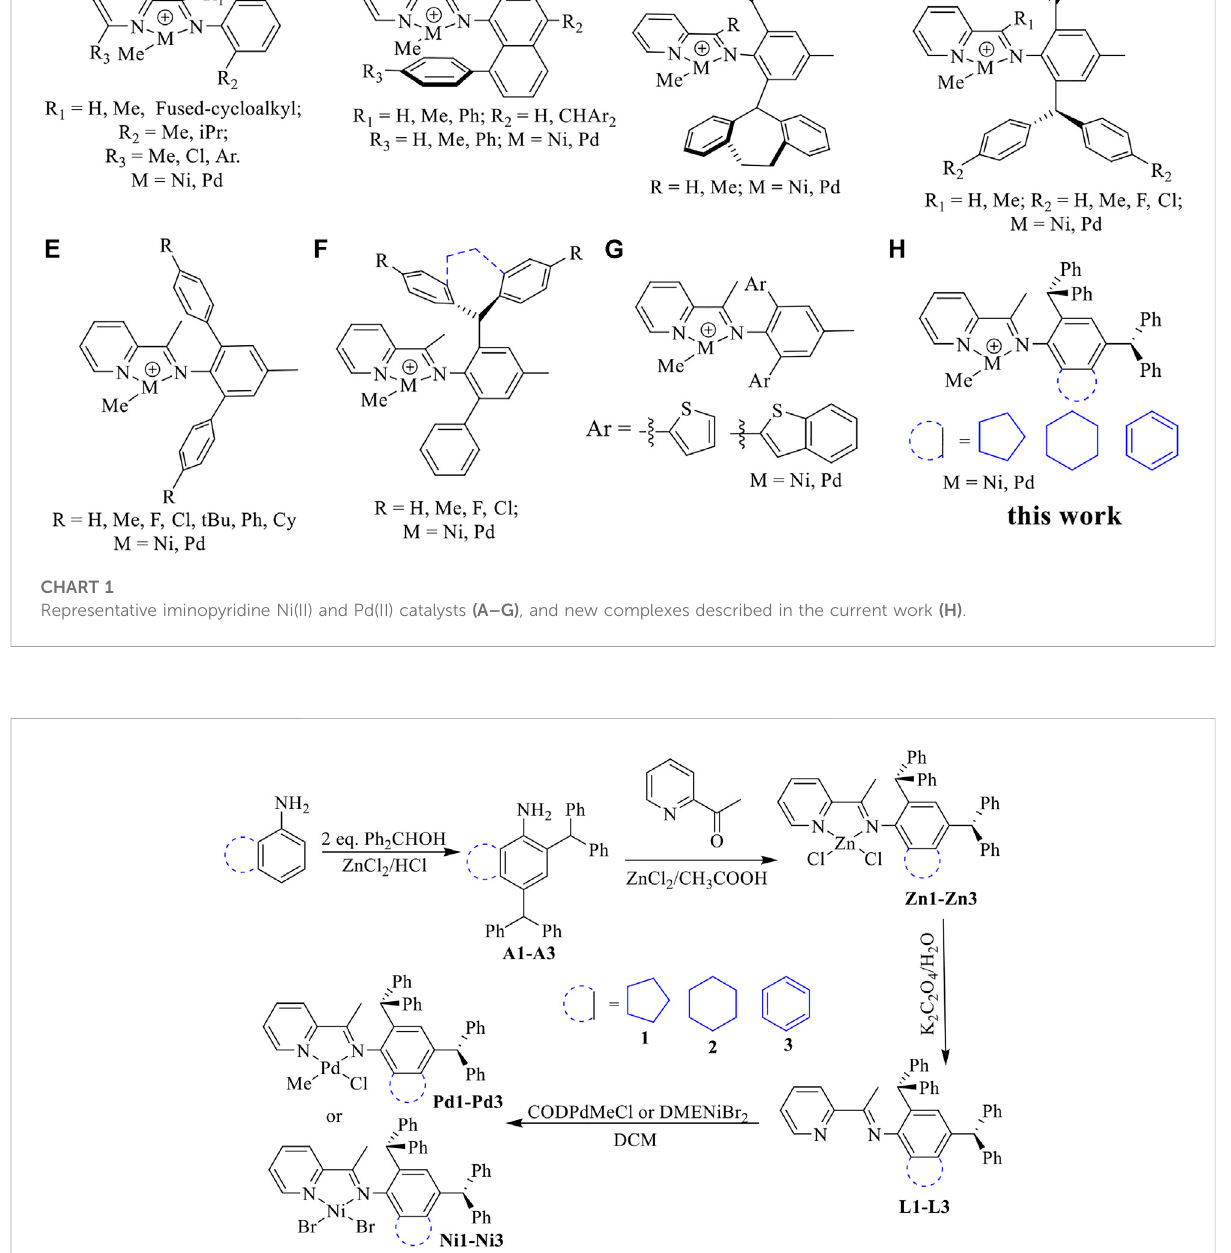
Single crystals of complex Pd2 were obtained by layering its CH 2 Cl 2 solution with hexanes at room temperature. As shown in Figure 1, the Pd2 complex adopts an approximate square-